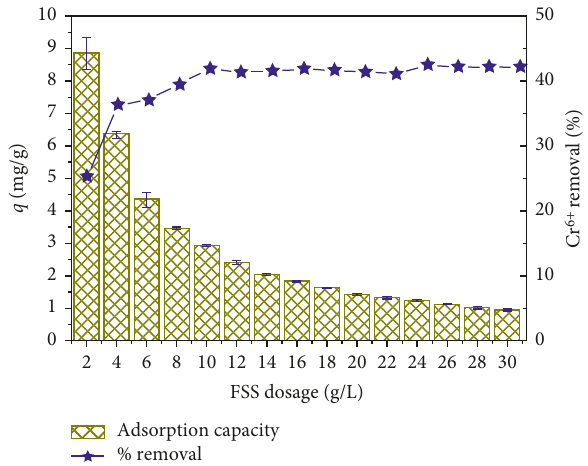
Figure 8: Effect of FSS dosage on Cr(VI) adsorption by FSS at 30mg/L of initial Cr(VI); pH 2; 20 ° C; 120min of contact time.